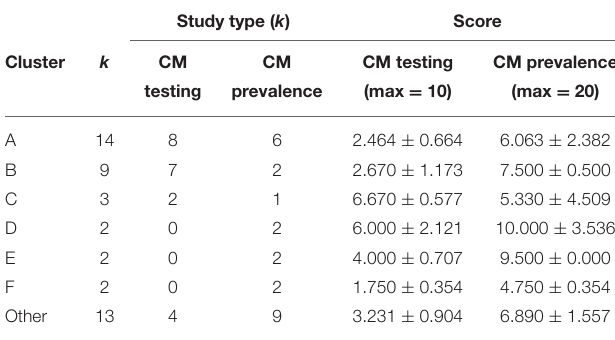
TABLE 7 | Average quality assessment scores by authors’